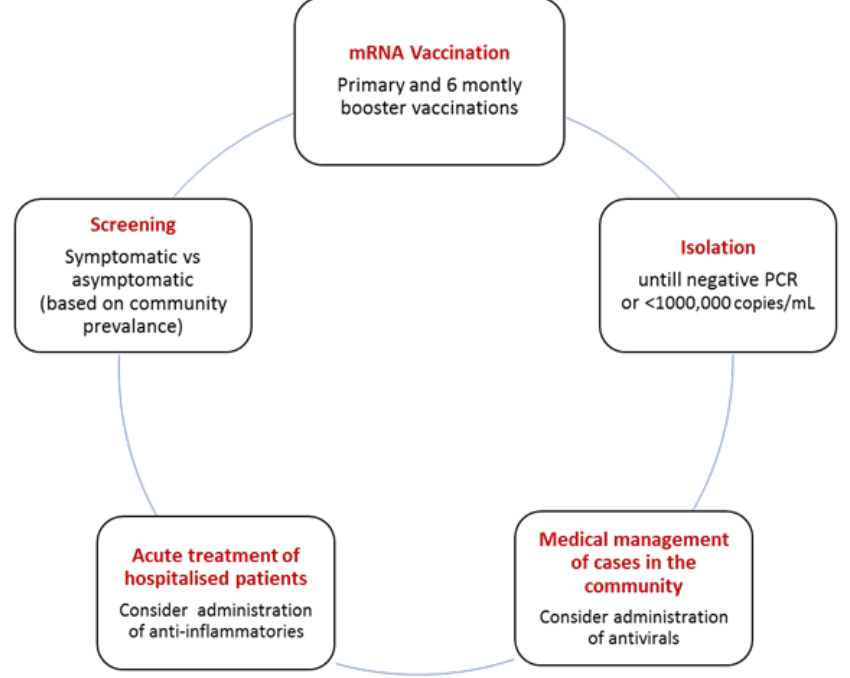
Figure 2. A pragmatic COVID-19 management approach for elderly patients receiving haemodi- alysis.